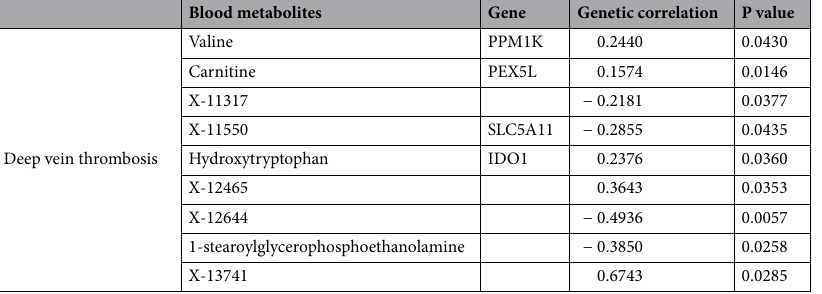
Table 1. Genetic correlation between human blood metabolites and deep vein thrombosis. LD score regression software (https:// github. com/ bulik/ ldsc) was used here to evaluate the genetic correlation between deep vein thrombosis and each of the human blood metabolites. So far, no genes related to the other five blood metabolites (X-11317, X-12465, X-12644, 1-stearoylglycerophosphoethanolamine, X-13741) have been found.